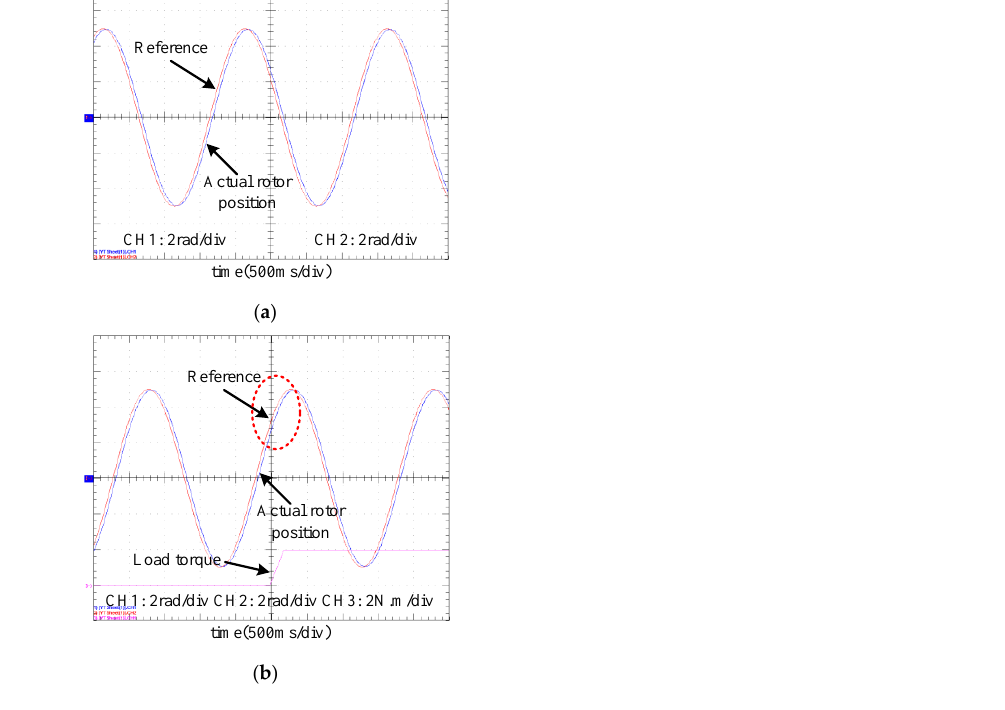
Figure 15. Rotor position and reference experimental results of the conventional NMPSC. ( a ) Steady-state; ( b ) Transient state. state; ( b ) Transient state.